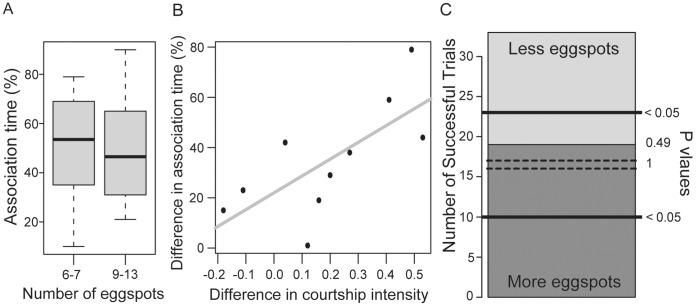
Results of behavioral trials.(A) Association times of the two groups of males with high and low numbers of eggspots. Boxes represent the interquartile range, the median is shown by the dark bar and outliers are displayed as circles; (B) Regression of association time on the difference in courtship intensity of the two males in each trial; (C) Number of trials won by males with lower (light grey) and higher (dark grey) numbers of eggspots is shown on the stacked barplot. The left axis shows the total number of trials (33) and the height of each stack represents the number of trials won. The right axis shows the associated significance values for a binomial test with 33 events. Values more extreme than the two full lines (>22 or <11) are significantly different from a 50% chance of winning.